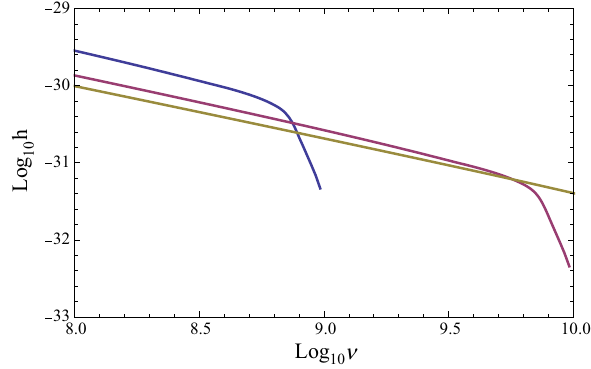
Fig. 2 The amplitude of SGWB for various chirp mass M c = 10 − 5 M (cid:2) , 10 − 6 M (cid:2) , 10 − 7 M (cid:2) , shown by the blue curve, the purple curve, and the brown curve,